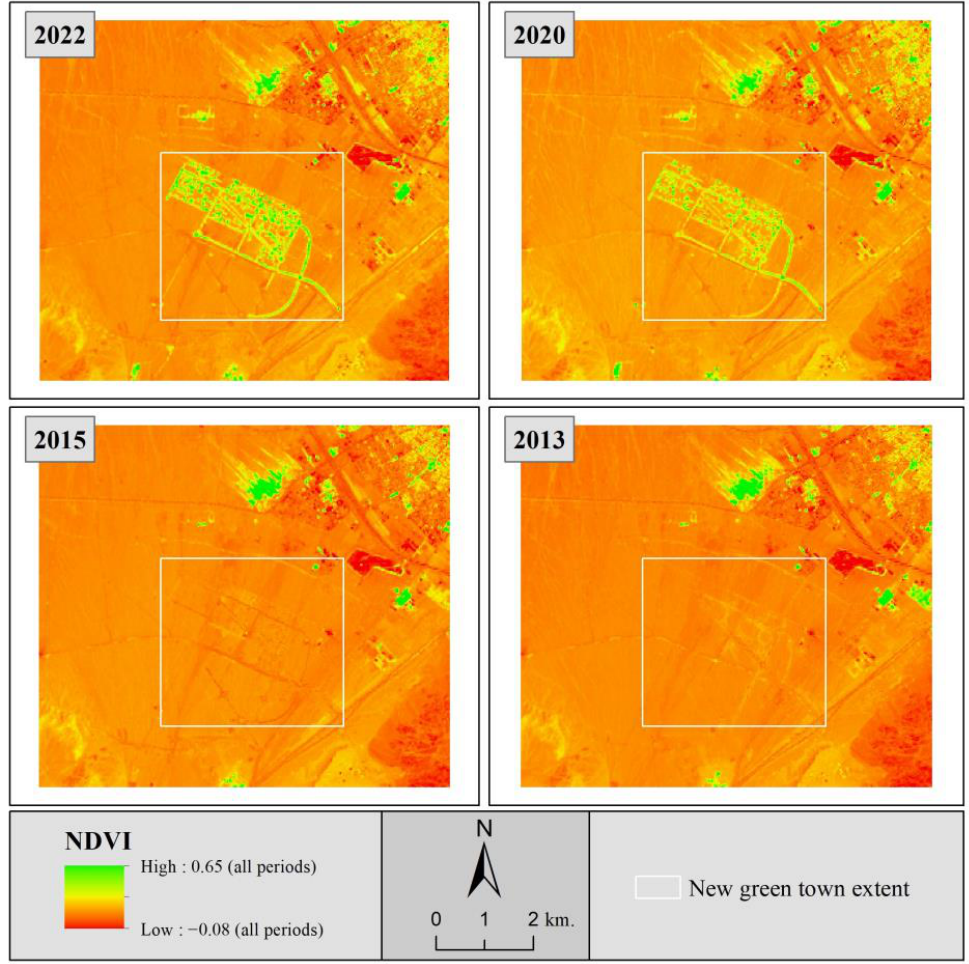
Figure 5. Normalized difference vegetation index (NDVI) maps for 2013, 2015, 2020 and 2022. The statistics of vegetation changes in the region clearly indicate an increasing trend of vegetation (Table 3). Thus, in the green zone, the NDVI minimum and maximum reached 0.12 and 0.61 in 2022 from 0.05 and 0.08 in 2013, respectively. A decrease of 0.01 is observed in the NDVI minimum and maximum in 2015. In addition, in the same period, the FVC minimum and maximum increased from 0.02 and 0.06 to 0.07 and 0.58, respectively. The NDVI and FVC means also increased from 0.12 and 0.04 to 0.45 and 0.42, respectively, with continuous growth in the three periods after 2013, i.e., 2015, 2020 and 2022. However, despite the differences, the RANGE values of 2020 compared to 2022 and 2013 compared to 2015 were very close to each